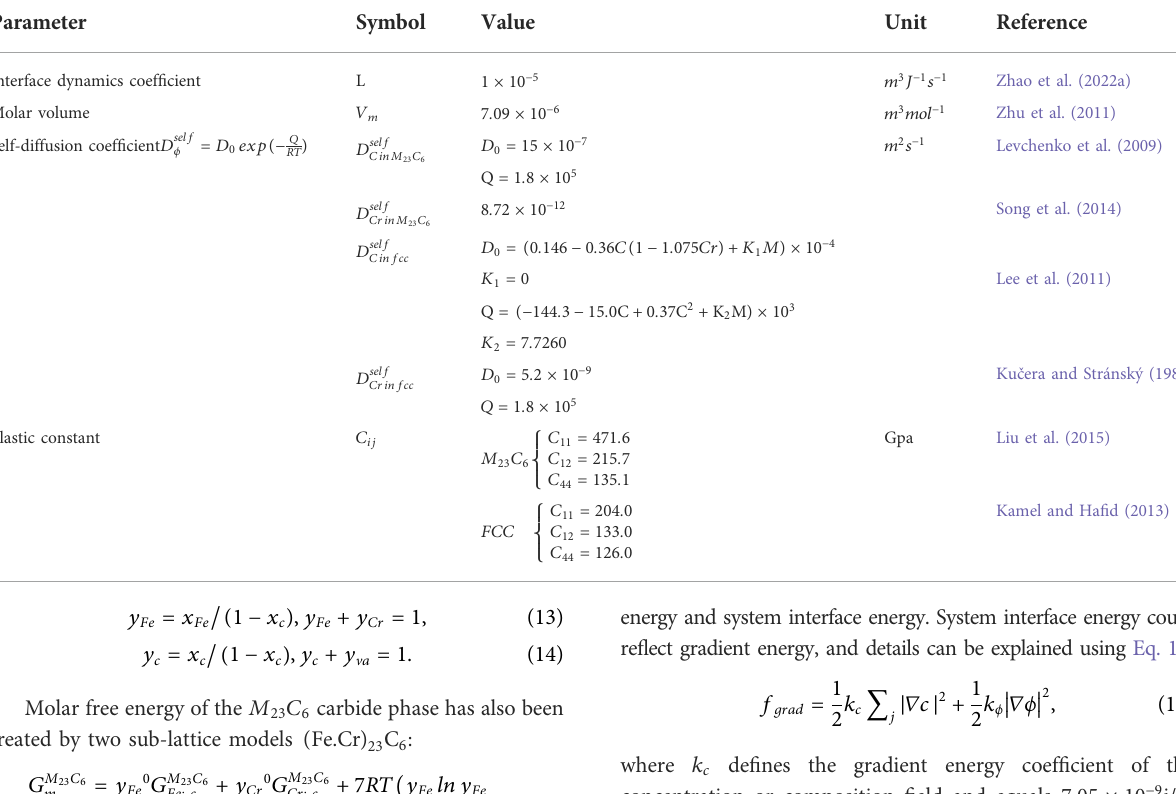
represents the Gibbs free energy of the pure binary carbide.